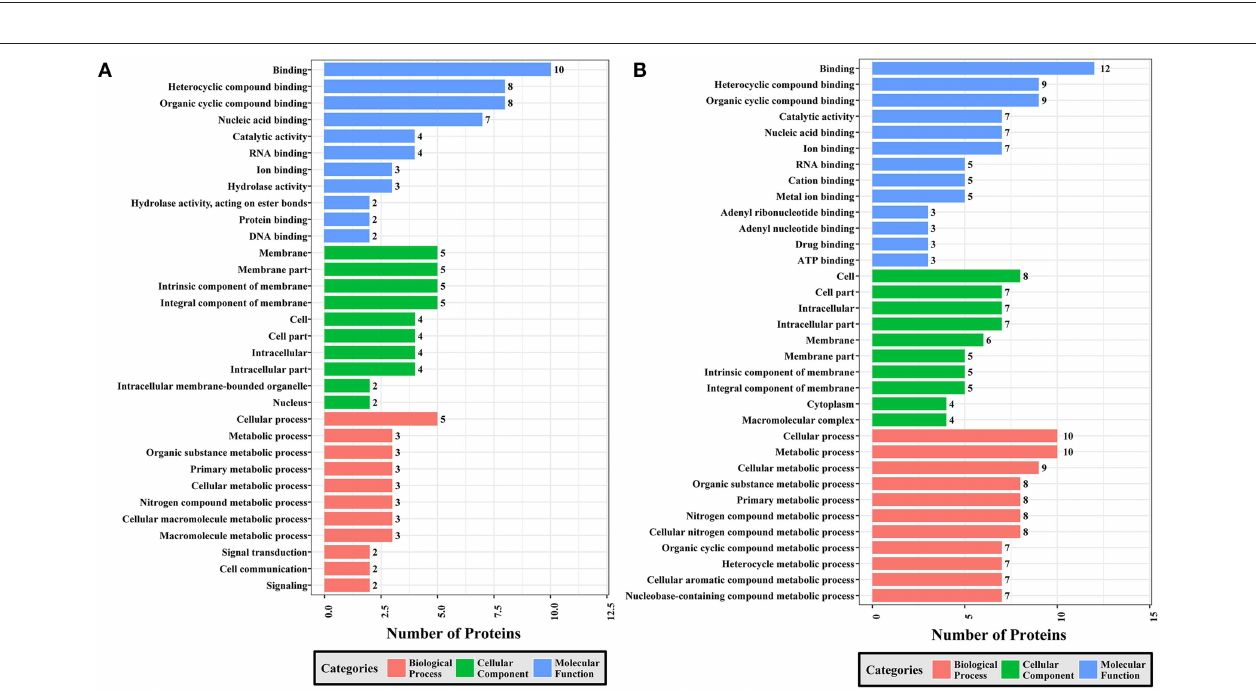
FIGURE 7 | GO analysis of phosphoproteins up/down-regulated in PRU strain when comparing PRU/PYS strains. The X-axis indicates the number of DEPs. The Y-axis represents GO terms of (A) upregulated and (B) downregulated phosphoproteins in PRU strain when comparing PRU/PYS strains, respectively.